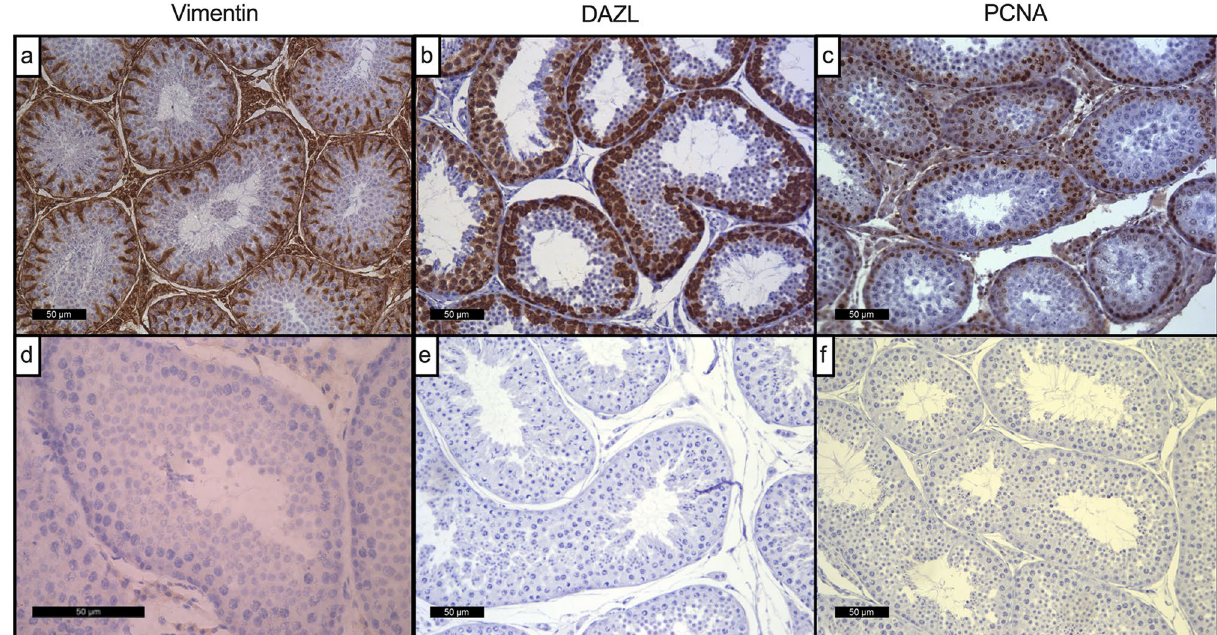
Figure 3. Immunohistochemical staining of mature dog testes for vimentin, DAZL and PCNA. Intense diffuse nuclear staining of Sertoli cells was observed for vimentin ( a ) and spermatogonia for both DAZL ( b ) and PCNA ( c ). Images ( d – f ) depict respective IgG negative controls. Scale bar represents 50